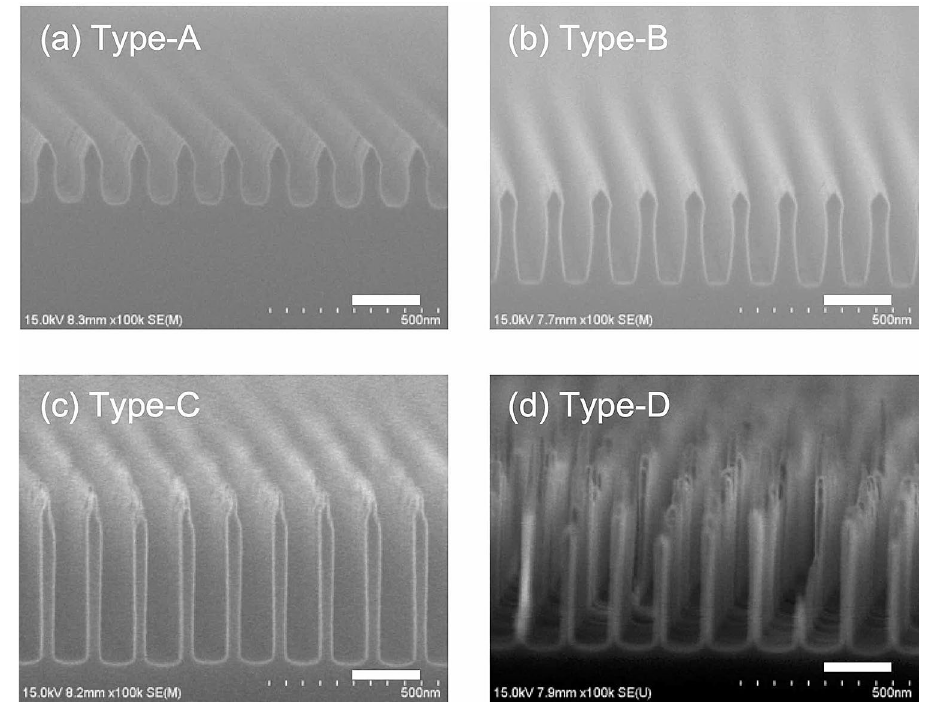
Figure 5. SEM images of the moulds used for the nanoprinting process. The white scale bars in each image represent 200